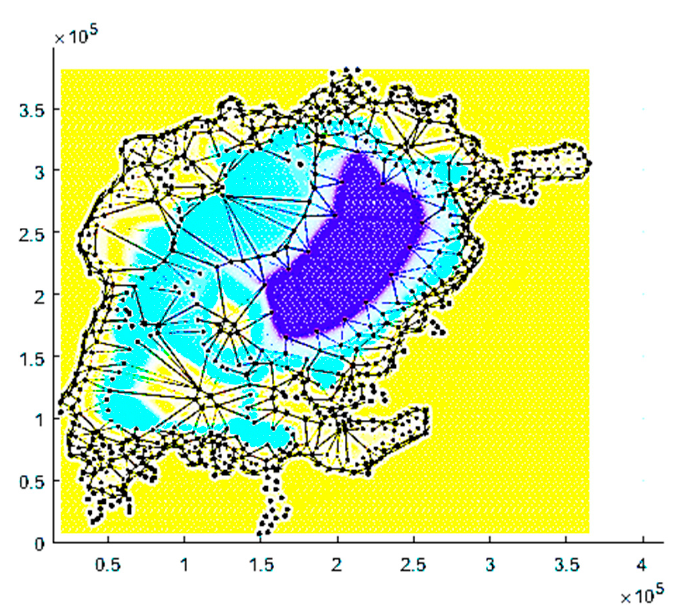
Figure 6. Delaunay triangulation and interpolation to old iso-curve data and manual close-to-shore points.